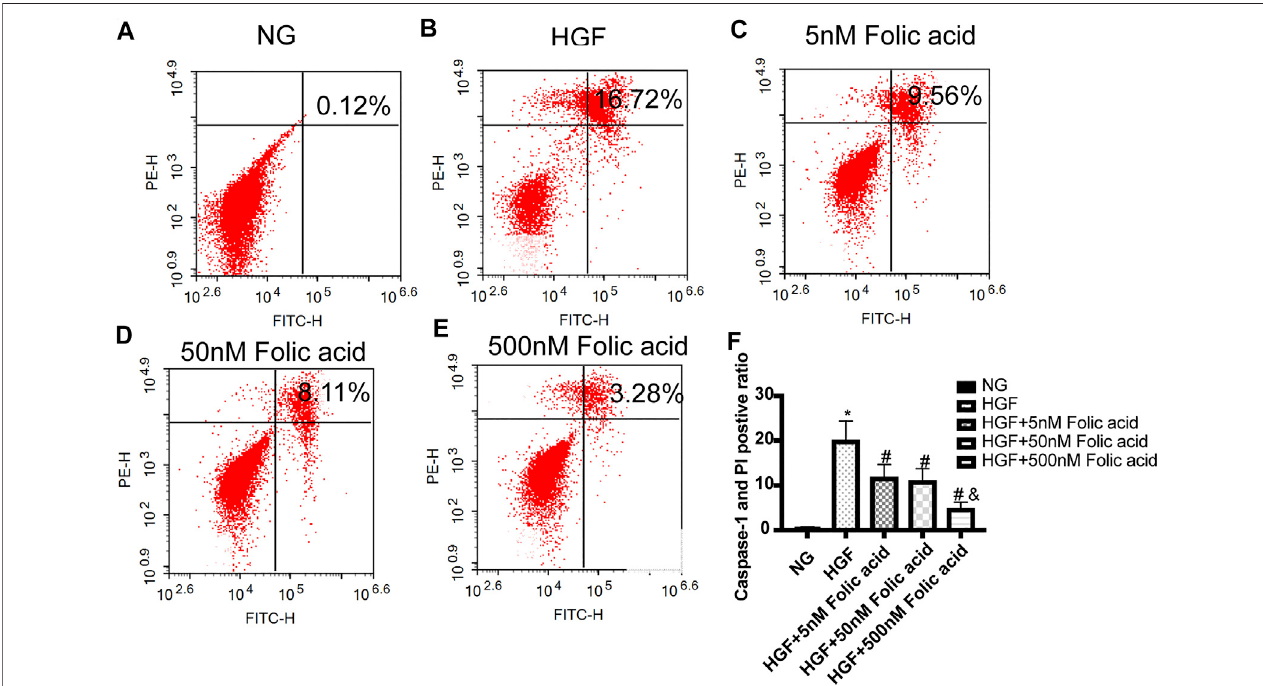
FIGURE 2 | Effect offolic acid on the ratio ofpyroptotic H9C2 cells. (A – E) Representive fl ow cytometry plots showing percentage of pyroptotic H9C2 cells treated with NG, HGF, 5 – 500 nM folic acid and HGF (F) Percentage of Annexin V and 7-AAD positive cells. * p < 0.05, compared with NG; # p < 0.05, compared with HGF; & p < 0.05, compared with HGF+50 nM folic